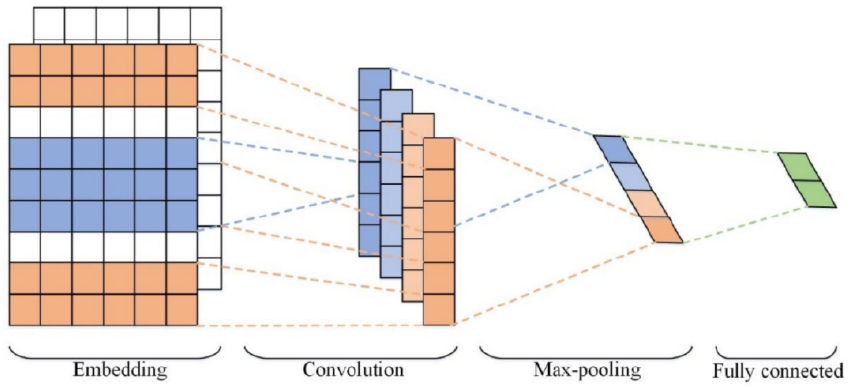
Figure 1. Illustration of CNN (Redrawn from